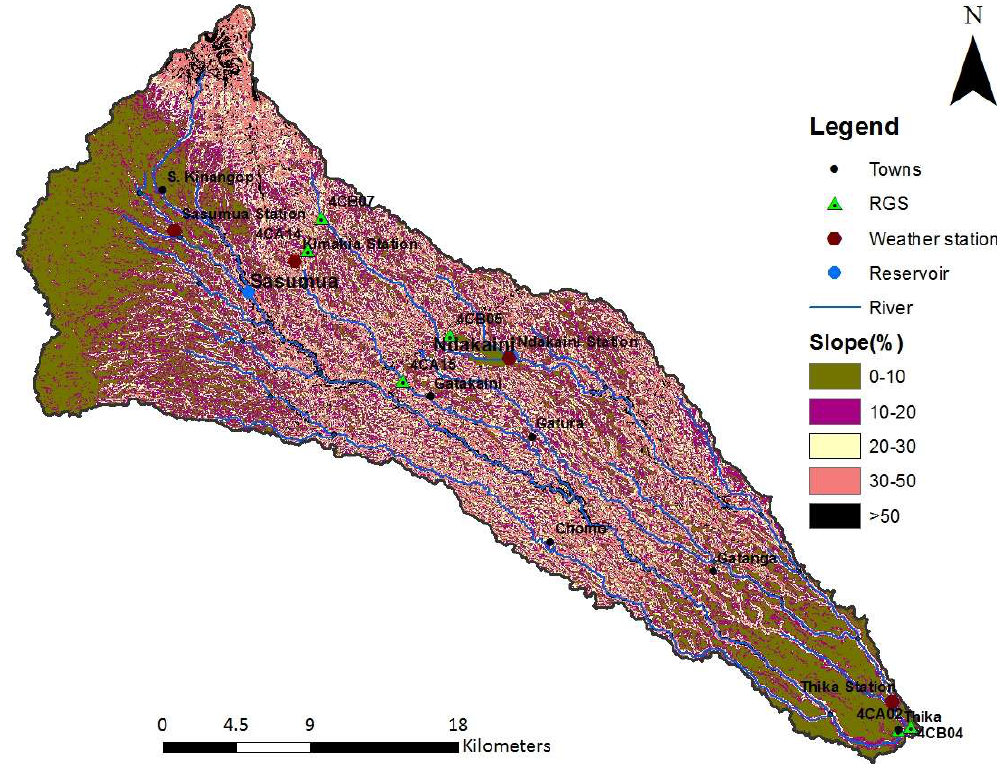
Figure 3. Slope variation at Thika-Chania catchment.